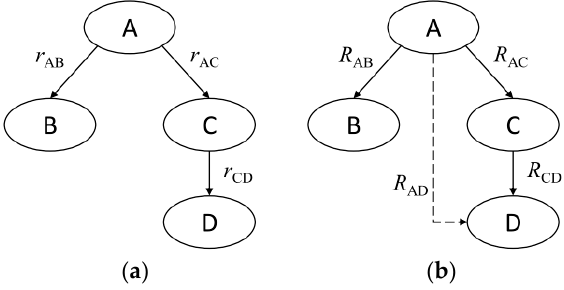
Figure 2. Sample ( a ) DRG and ( b ) DRGEP diagrams.